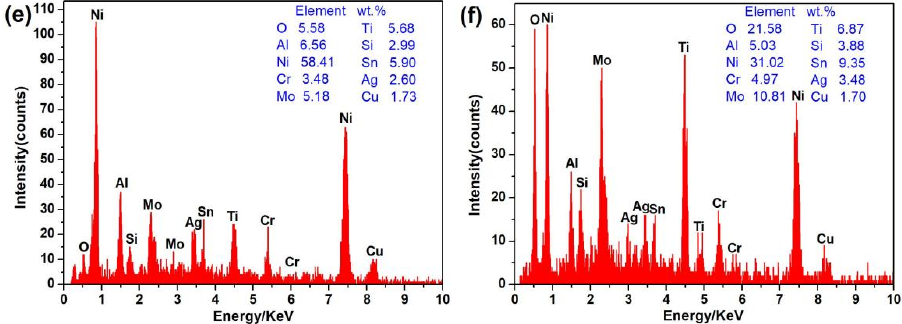
Figure 6. Worn surface morphologies of NBA, NS, NT and NST at 400 °C ( a – d ); EDS results of the areas marked by boxes A and B in Figure 5d: box A at the edge zone of the worn surface ( e ), box B at the crack healing area ( f ).